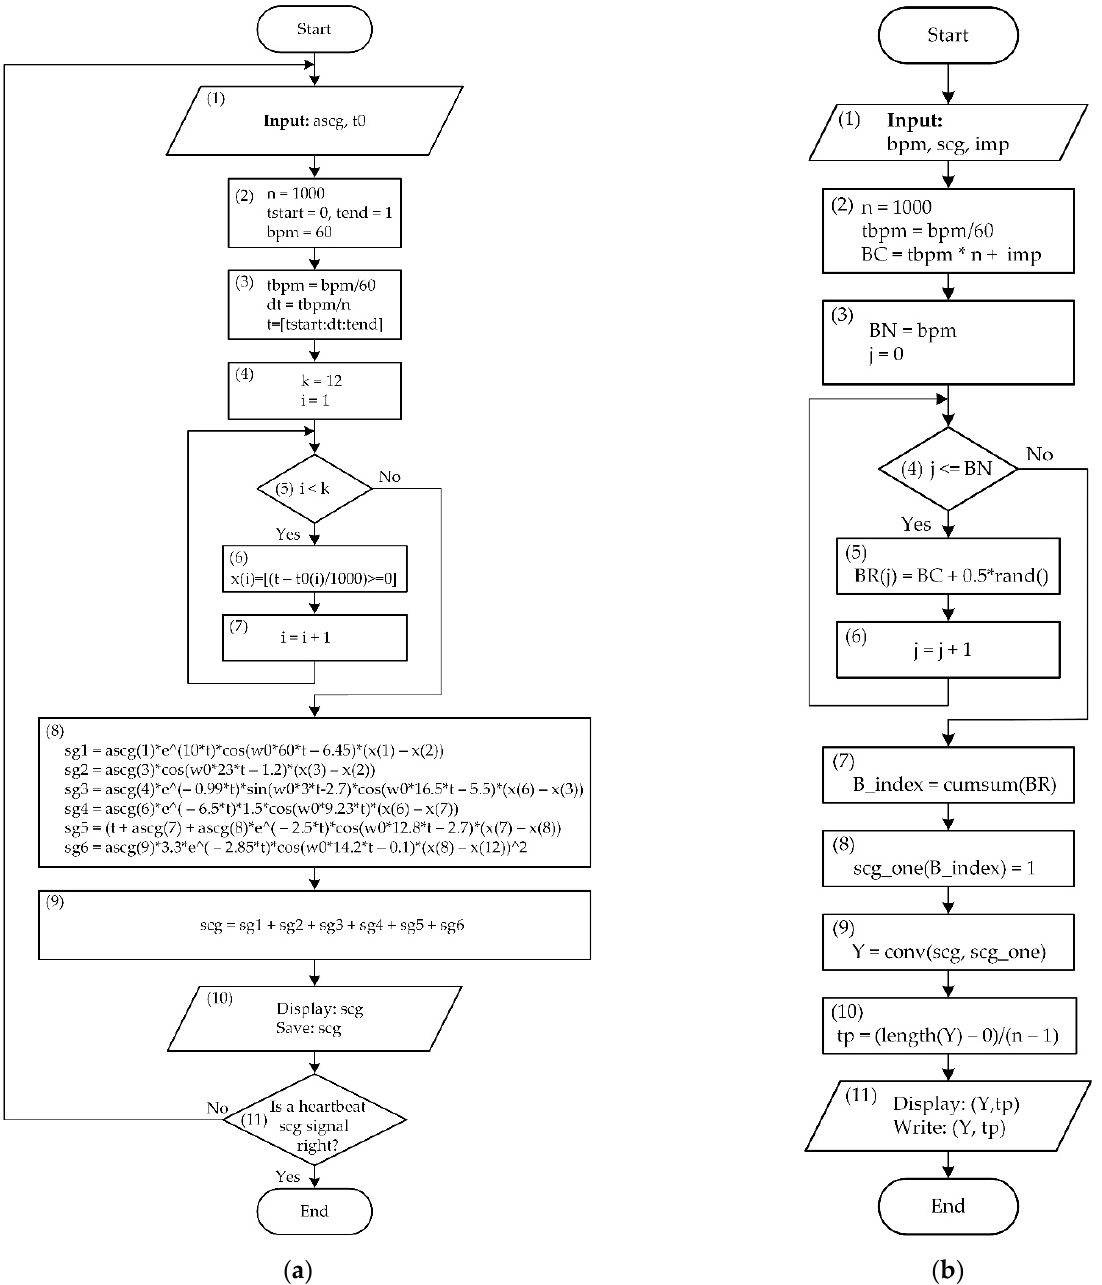
Figure 1. Modeling the seismocardiogram signal sequence without noise algorithms: ( a ) Creation of a heartbeat seismocardiogram signal algorithm; ( b ) modeling the SCG signal without noise algorithm. Where: ascg = { ascg1 , ascg2 , ascg3 , ascg4 , ascg5 , ascg6 , ascg7 , ascg8 , ascg9 }—SCG data artifacts acceleration values set; t0 = { tas , tmc , tim , tao , tic , trbe , trbee , tac , tmo , trbf , trbfe , te }—SCG data fiducial points time values set; tstart —start time in seconds; tend —end of one heartbeat in seconds; n —number of samples equal to 1000 ms; dt —step of time difference; bpm = heart rate beats per minute; imp —additional impulses for anti ‐ alliancing heartbeats; BC —beat countdown; BN —beats number for generation one minute sequence; BR —set of random beats; Y —SCG signal sequence; tp —duration of SCG sequence.